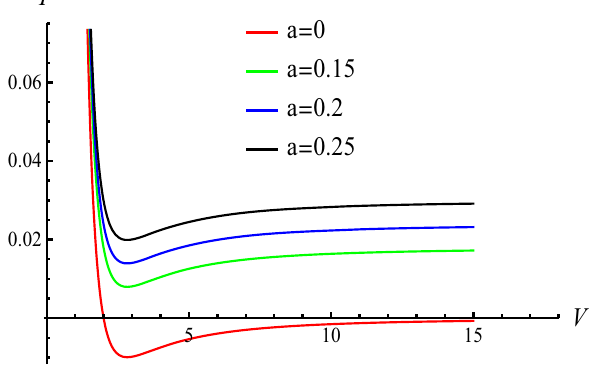
Fig. 9 Thefour T = 0isothermsareplottedinthecase ω q = − 1.With the increase of the parameter a , the isotherms with fixed temperature ( T = 0 here) will move to the upper region of the P – V plane such that the fixed thermodynamical cycle would be shifted from the physical region to the unphysical region as the cycle with ω q = − 2 / 3 does